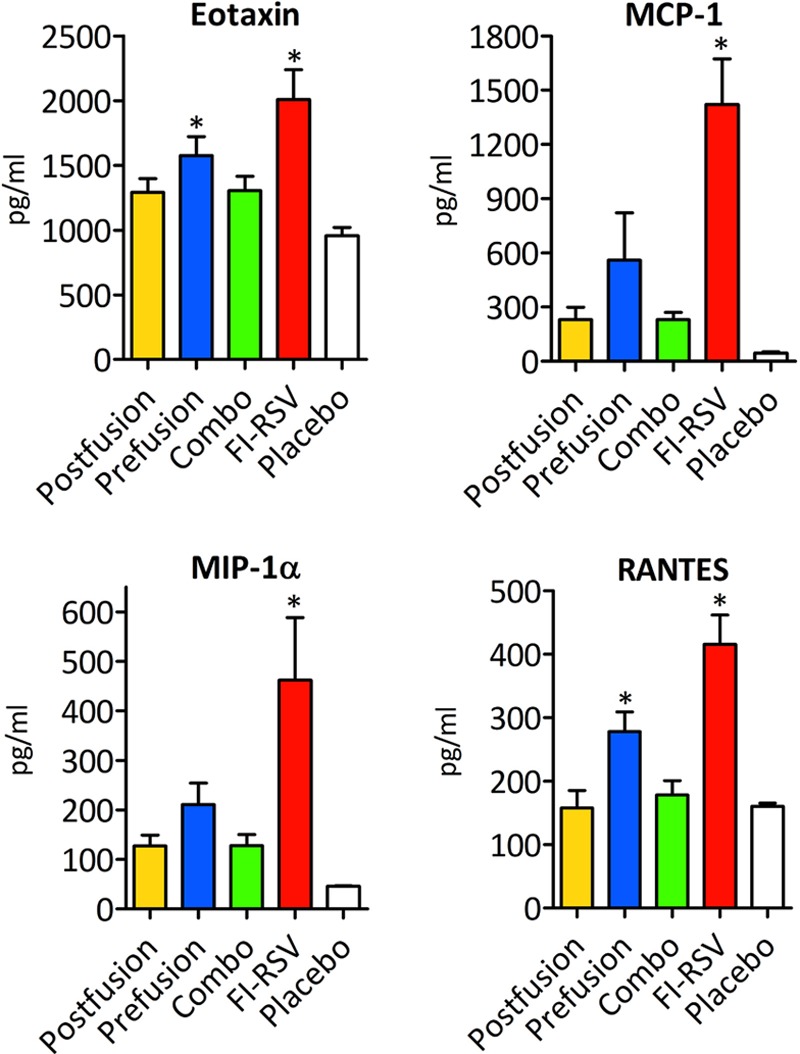
Chemokine responses in VLP-vaccinated mouse lungs after RSV infection. Analyses include eotaxin, MCP-1, MIP-1α, and RANTES. The results were generated using a group of 4 mice for each condition at 4 days postinfection. An asterisk indicates a statistically significant difference between an experimental condition and the placebo control (P < 0.05). Differences between the FI-RSV and the VLP vaccines are also statistically significant (P < 0.05) in all groups.